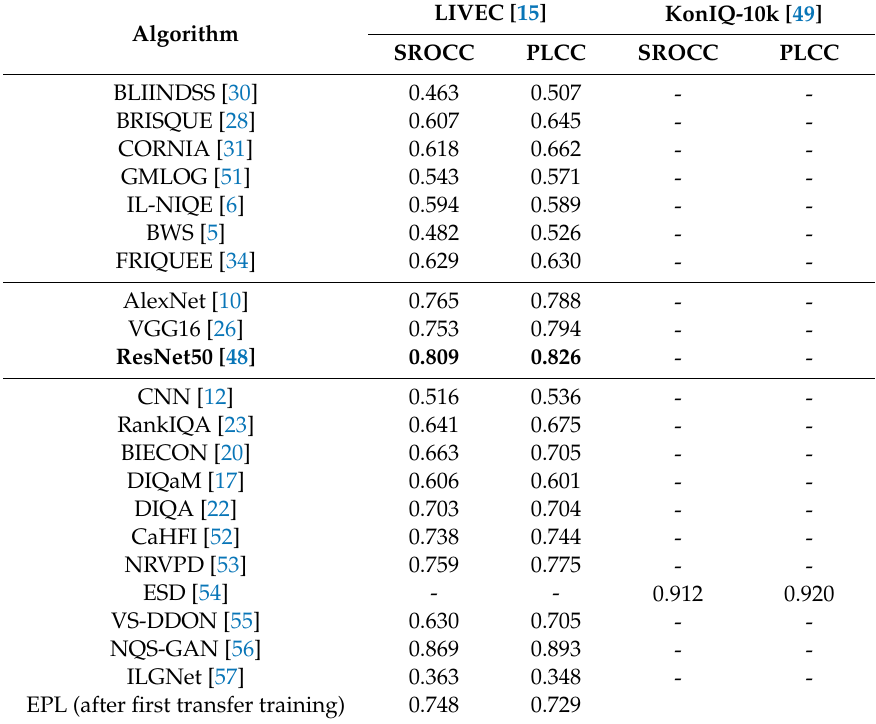
Table 5. Performance comparison between the proposed algorithm (after first stage training) and other